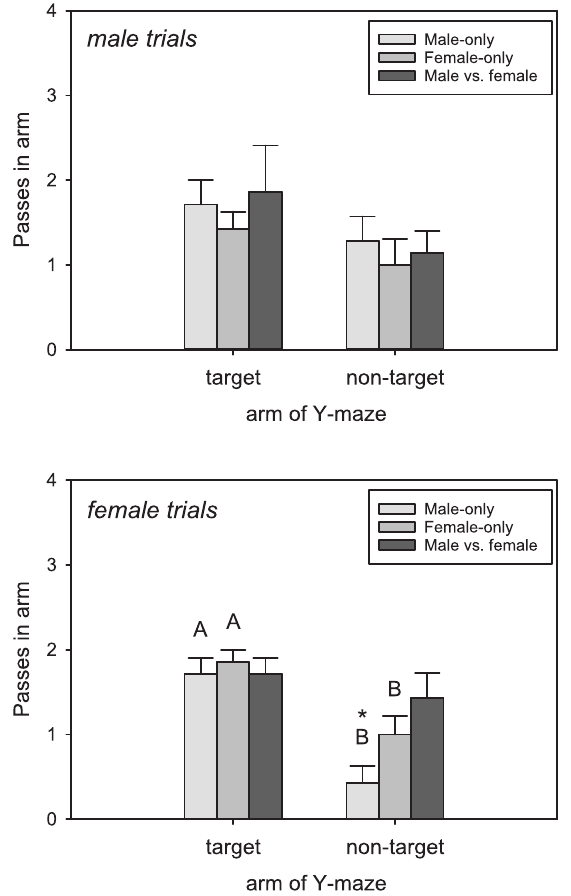
Fig 3. Number of passes through each arm of the Y-maze. Tegus differentially explored the Y-maze across the trial types based on number of arm passes. Top, males; bottom, females. Different letters (uppercase) represent statistically different (P < 0.05) pairwise comparisons between target and non-target arms within a trial type. Bars are means (+SEM).